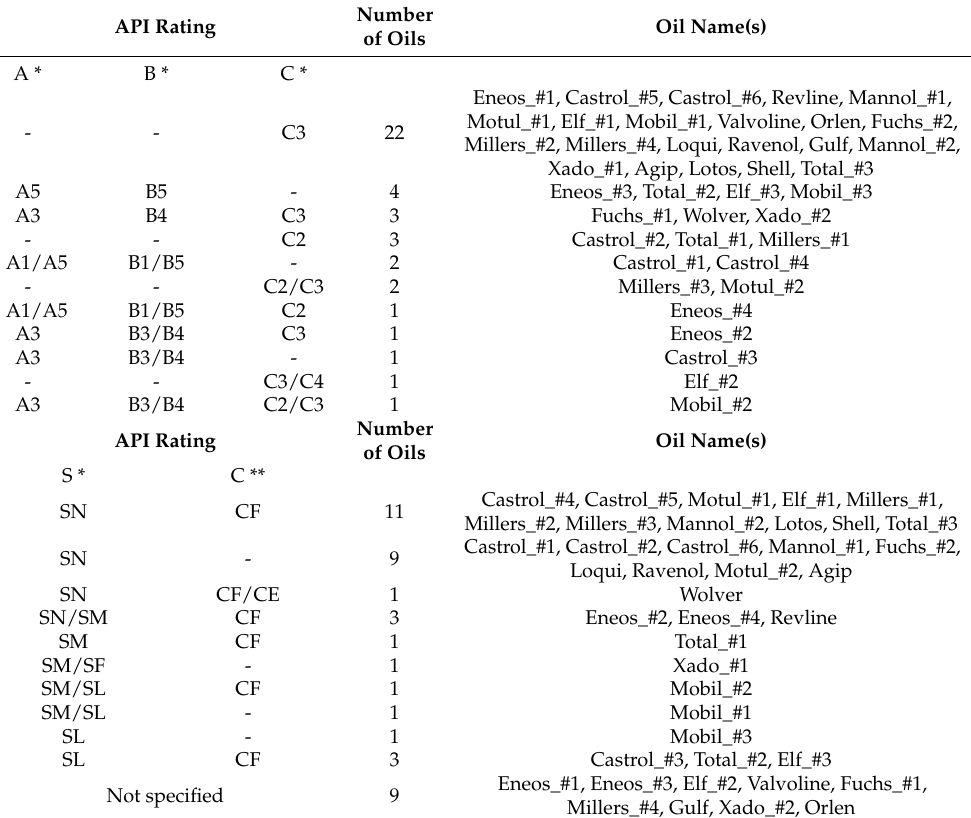
Table 2. Number of oils per each quality rating (ACEA,